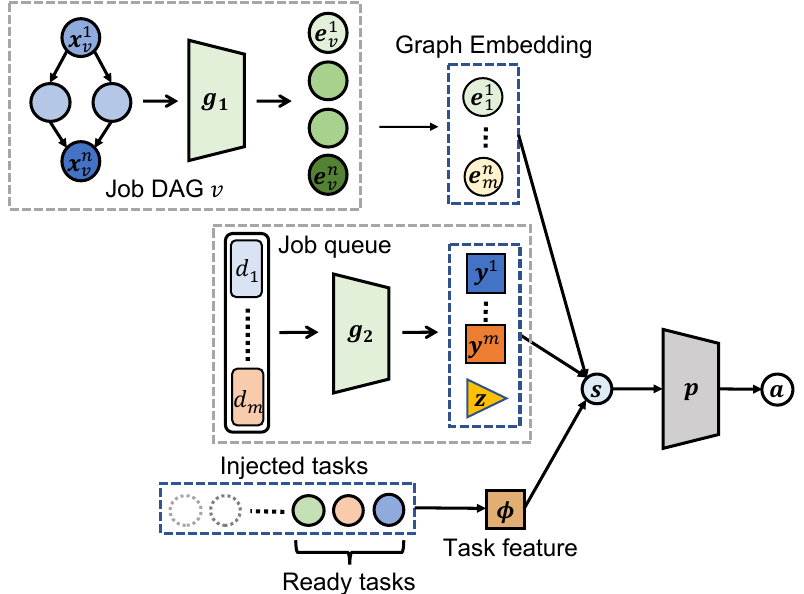
Figure 5. The task ordering is trained via DeepSoCS architecture. The state is composed of graph embeddings and task features. A node-level MPNNs, g 1 , computes embedding nodes for each job injected in the job queue, and a job-level MPNNs, g 2 , computes local and global summaries using node embeddings and injected jobs information. Then, the onward task information constructs task features, which represent the number of possible actions. We use conventional policy networks p to select a